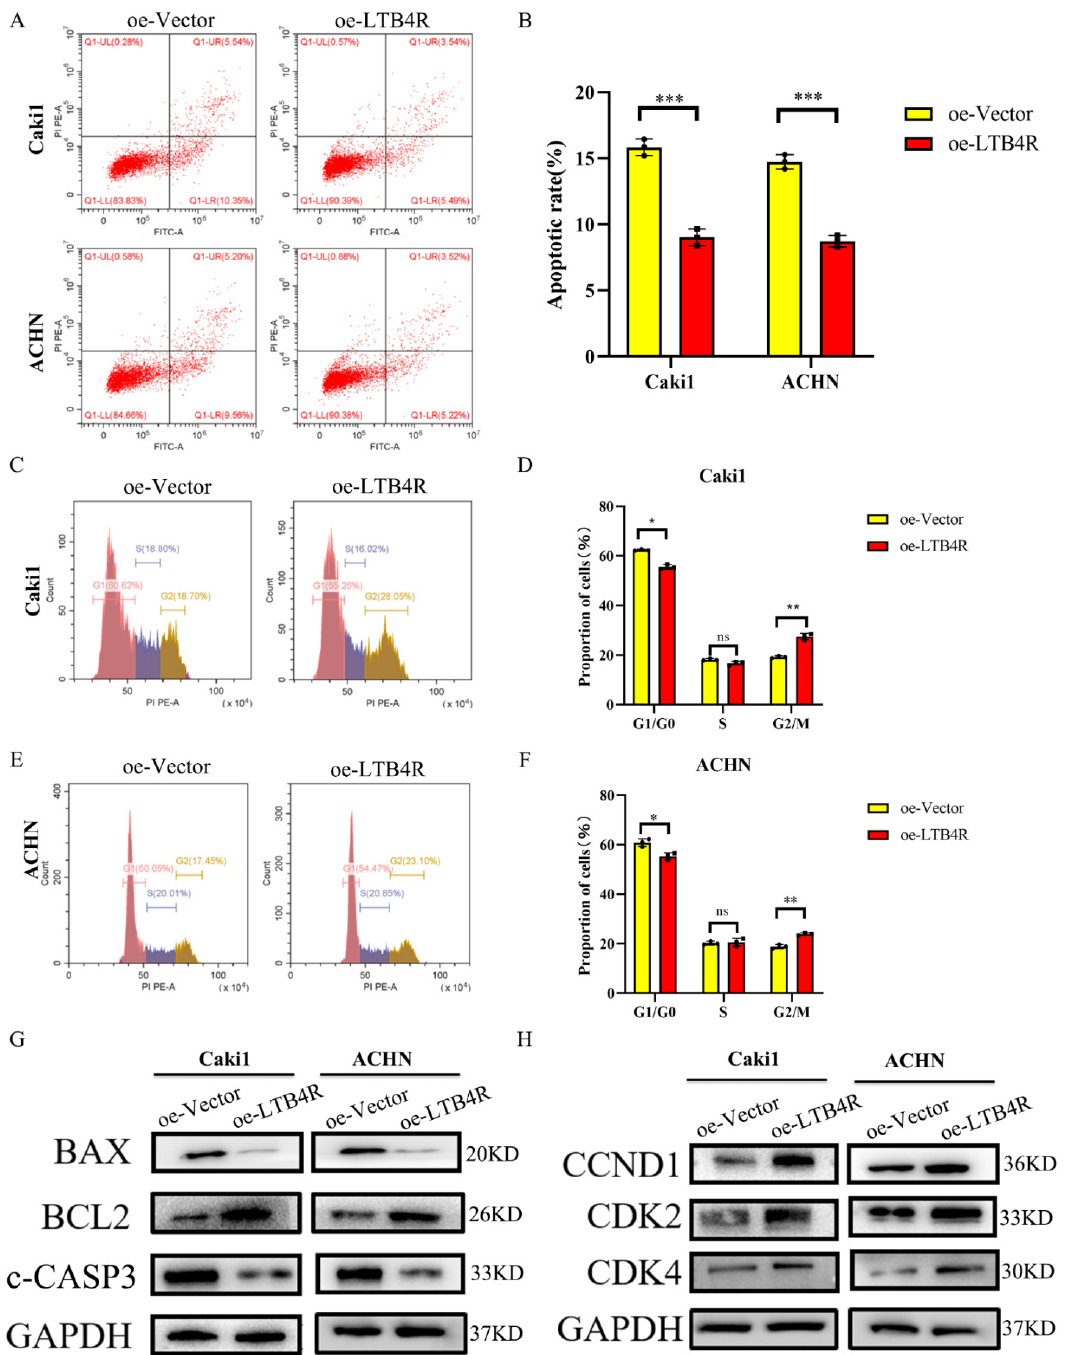
Figure 5. LTB4R overexpression promoted the cell period and inhibited apoptosis of ccRCC cells. ( A , B ) LTB4R overexpression inhibited apoptosis of Caki1 and ACHN cells, respectively. ( C – F ) After LTB4R overexpression, the proportion of G1/G0 phase in Caki1 and ACHN cells decreased, whereas the proportion of G2/M phase increased, and the proportion of S phase did not significantly change. ( G ) Western blot analysis showed that after LTB4R overexpression, the expression of apoptosis-related